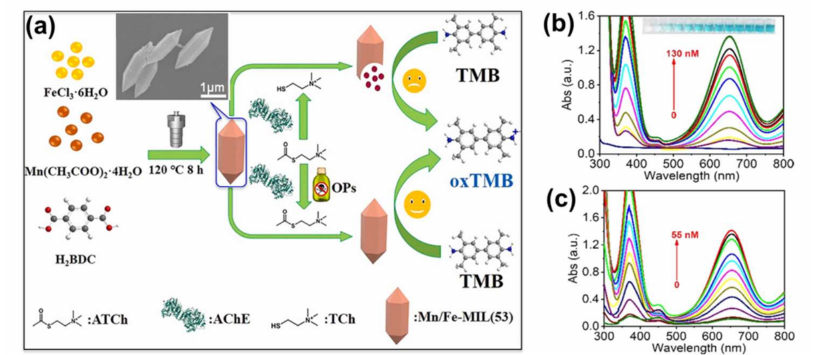
Figure 16. ( a ) Representation of the sensing process of Mn/Fe-MIL(53) MOF nanoenzyme for OPs detection. UV–vis spectrum of nanoenzyme-TMB catalyzed system corresponding to different dosages of methyl parathion ( b ) and clorpyrifos ( c ). Adapted from [121]. Nonorganic Phosphates